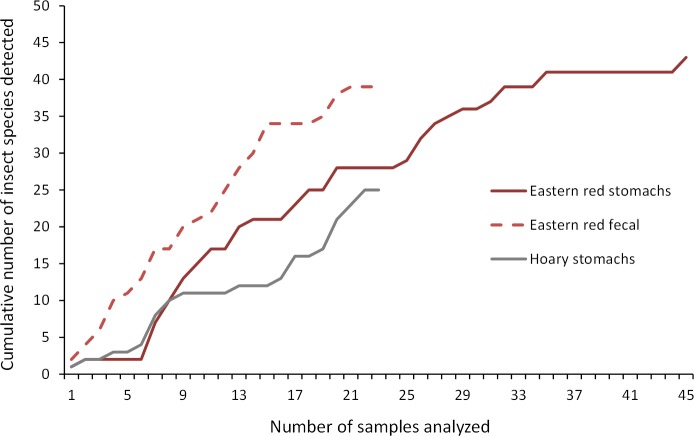
Discovery rate of new insect species in bat stomachs and fecal pellets.Discovery rate of new insect species by number of bat stomachs and fecal pellets analyzed from the Wolf Ridge wind farm.